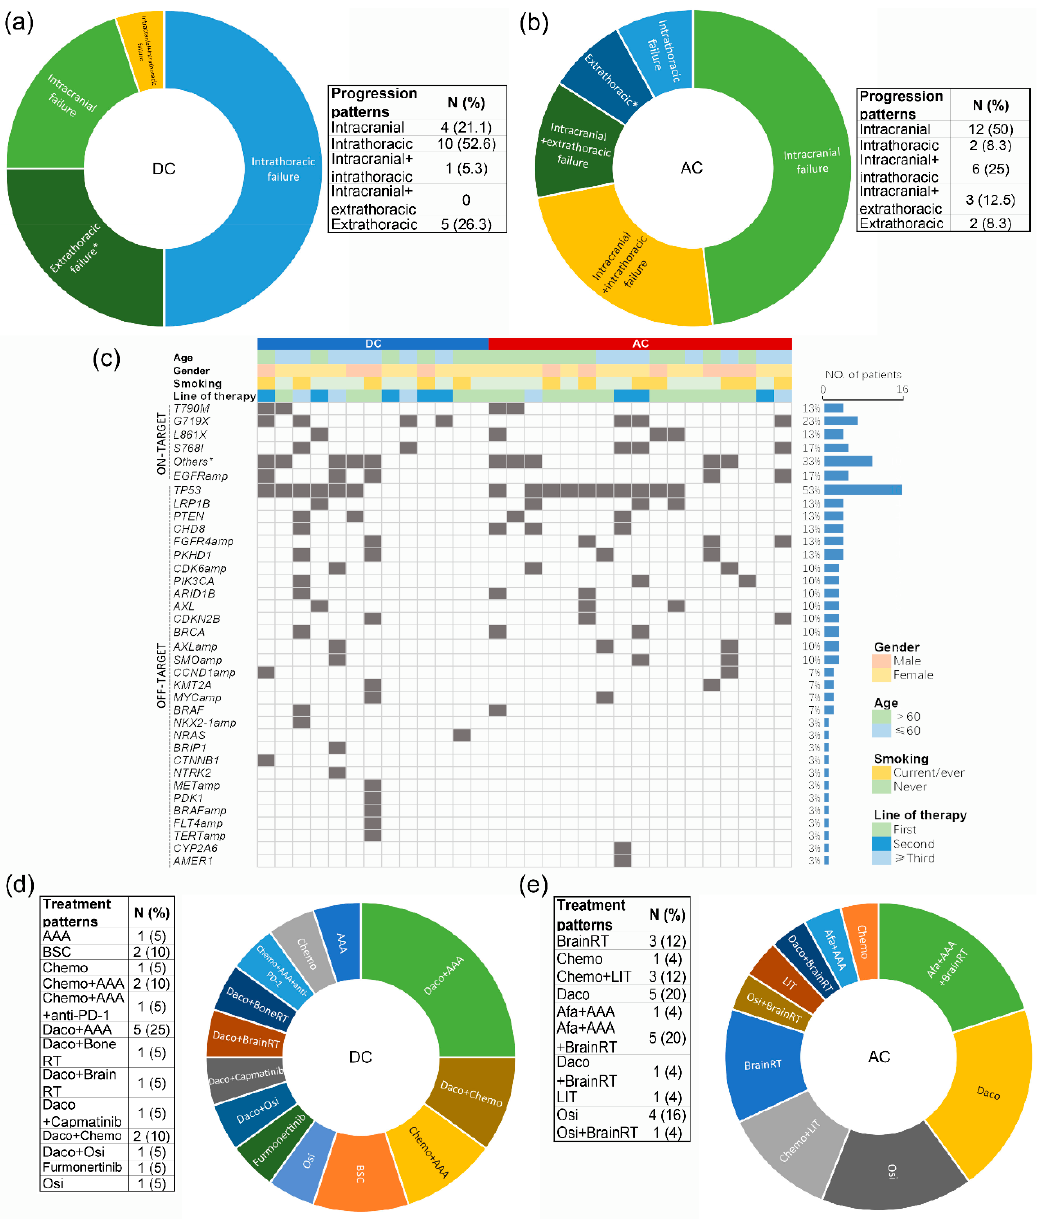
Figure 5. Progression patterns (a – b), resistance mechanisms (c), and bridging therapies (d – e) in the DC and the AC. AAA, anti-angiogenic agent; RT, radiotherapy; Chemo, chemotherapy; Daco, dacomitinib; Osi, osimertinib; LIT, local intervention therapy; PD-1, programmed cell death protein 1; amp, amplification; DC, dacomitinib cohort; AC, afatinib cohort. * Uncommon EGFR mutations other than major ones, T790M, and EX20ins. The non- EGFR mutations presented were all identified as resistance mechanisms rather than as present in the original tumor.